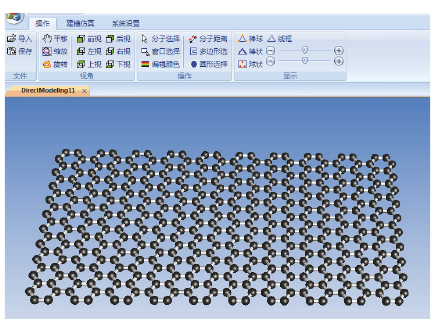
Figure 18: User interface of the prototype